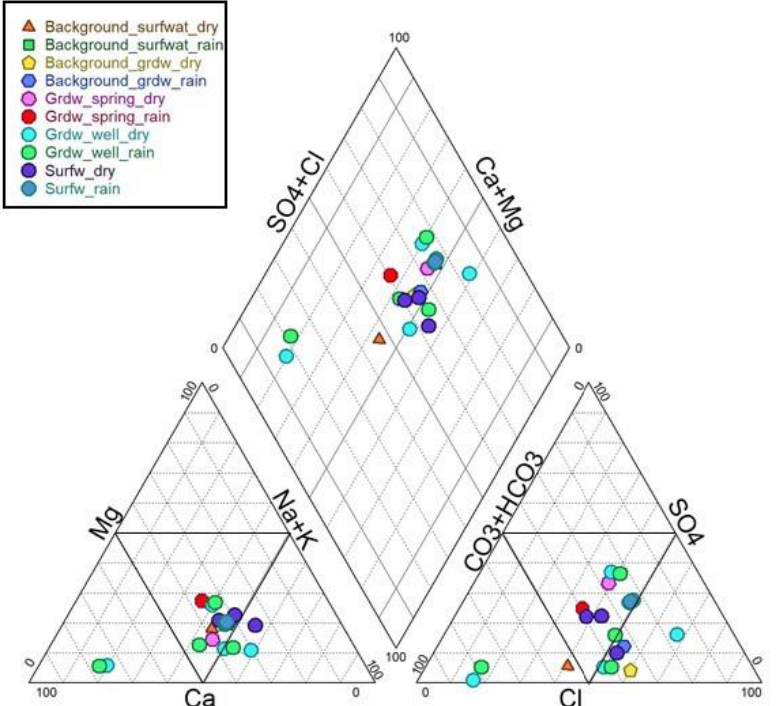
Figure 5. Hydrochemistry classification (Piper diagram) of the water from the Picoto mine area. Surfwat—Surface water; Grdw—Groundwater. Diagrammes software was used for computation purposes [39].